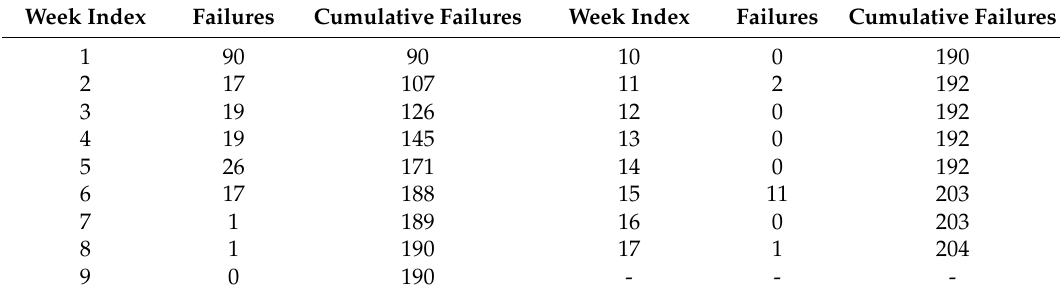
Table 3. DS2: medical record system (MRS) data set.